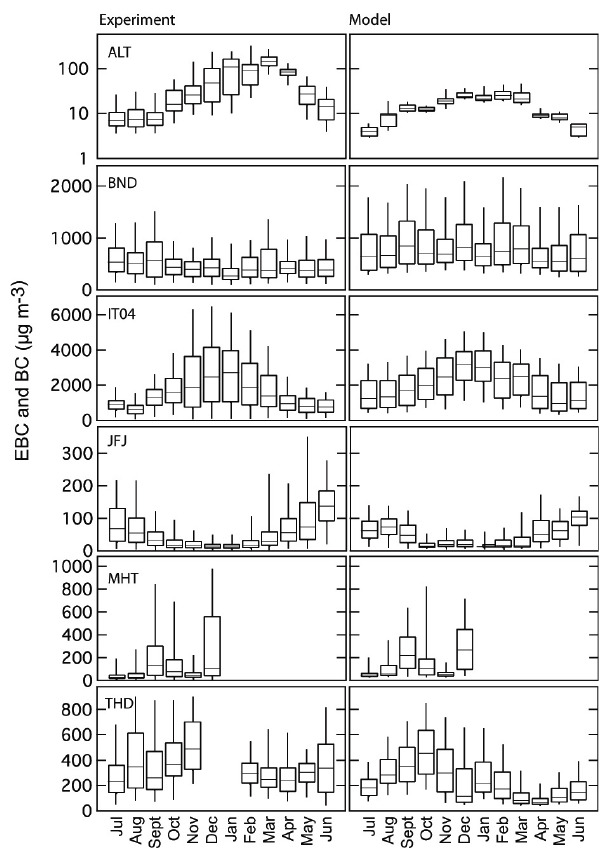
Fig. 4. Time series of experimental EBC and model BC concen- trations, from July 2002 to June 2003; central point of the boxes correspond to median values, boxes indicate 25th–75th percentile intervals, and whiskers indicate 95th-5th percentile